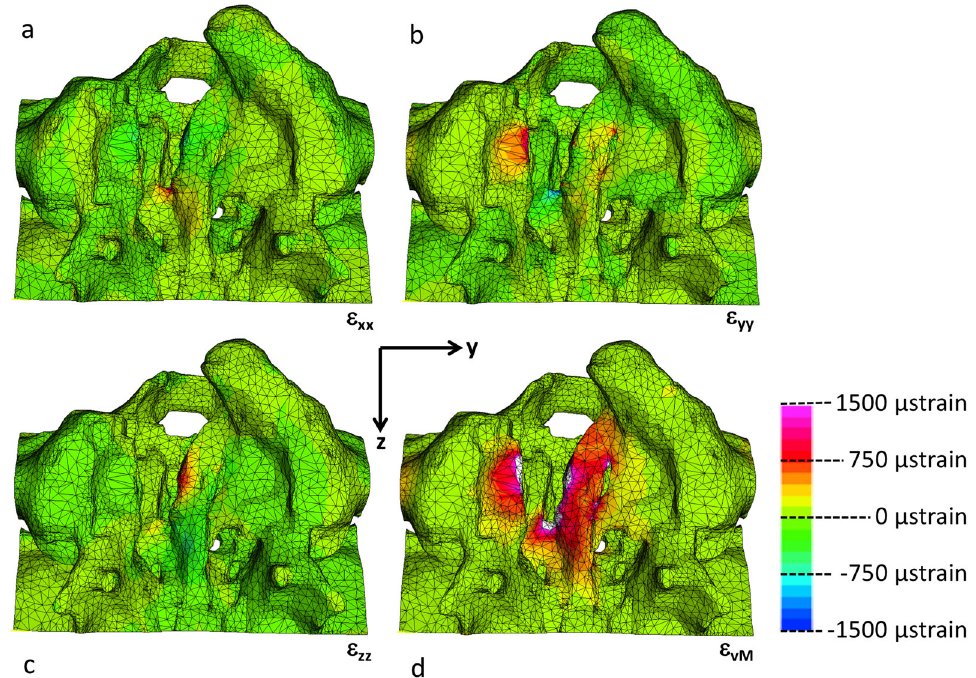
Fig. 5 The distribution of the three orthogonal strain components von Mises strains for magnetic attraction forces of 1 N a palatal view with the X-axis pointing coronally, b Y-axis pointing left, c Z-axis pointing posteriorly and d the strain intensity (von Mises strain)